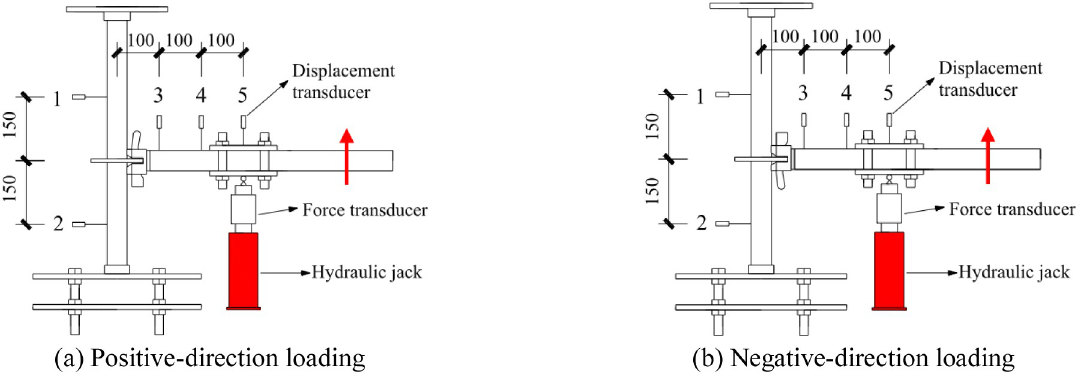
Fig 6. Arrangement of the displacement measuring points (unit: mm). (a) Positive-direction loading. (b) Negative-direction